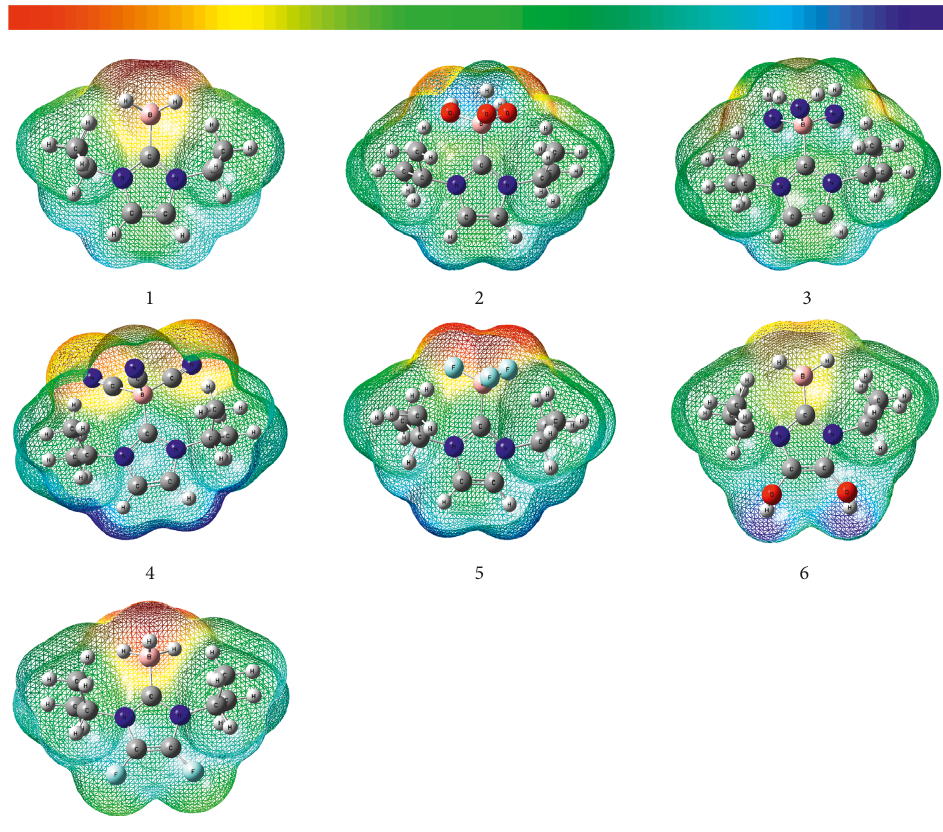
Figure 4: Electrostatic potential surface plot of the complexes at an isovalue of 0.001 a.u. Color ranges from red, more electronegative, through yellow to blue, more electropositive Table 6: Natural charge ( e ) of some selected atoms in the complex and isolated structures in addition to the BSSE corrected binding energies ( Δ E CP BE ) of the complexes. Molecule